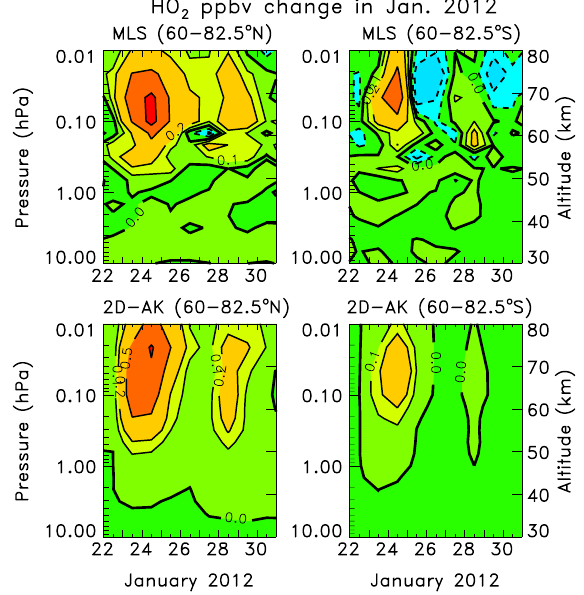
Fig. 3. Daily averaged HO 2 changes from Aura MLS measurements ( Top ) and GSFC 2-D model predictions ( Bottom ) for the 60–82.5 ◦ N band ( left plots ) and 60–82.5 ◦ S band ( right plots ). An average ob- served (predicted) HO 2 profile for the period 18–22 January 2012 was subtracted from the observed (predicted) HO 2 values for the plotted days of 22–30 January 2012. The contour intervals for the HO 2 differences are − 0.2, − 0.1, 0.0, 0.1, 0.2, 0.5, and 1ppbv. The MLS averaging kernel (AK) was used to sample the model